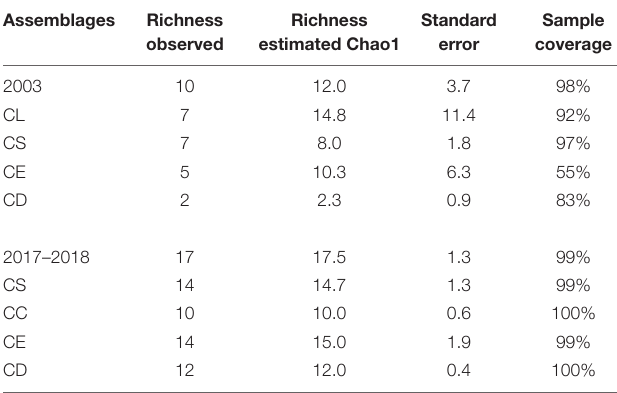
TABLE 3 | Observed and estimated species richness, with standard errors and sample coverage, of small mammals for the 2003 and 2017–2018 surveys in distinct habitats surveyed at